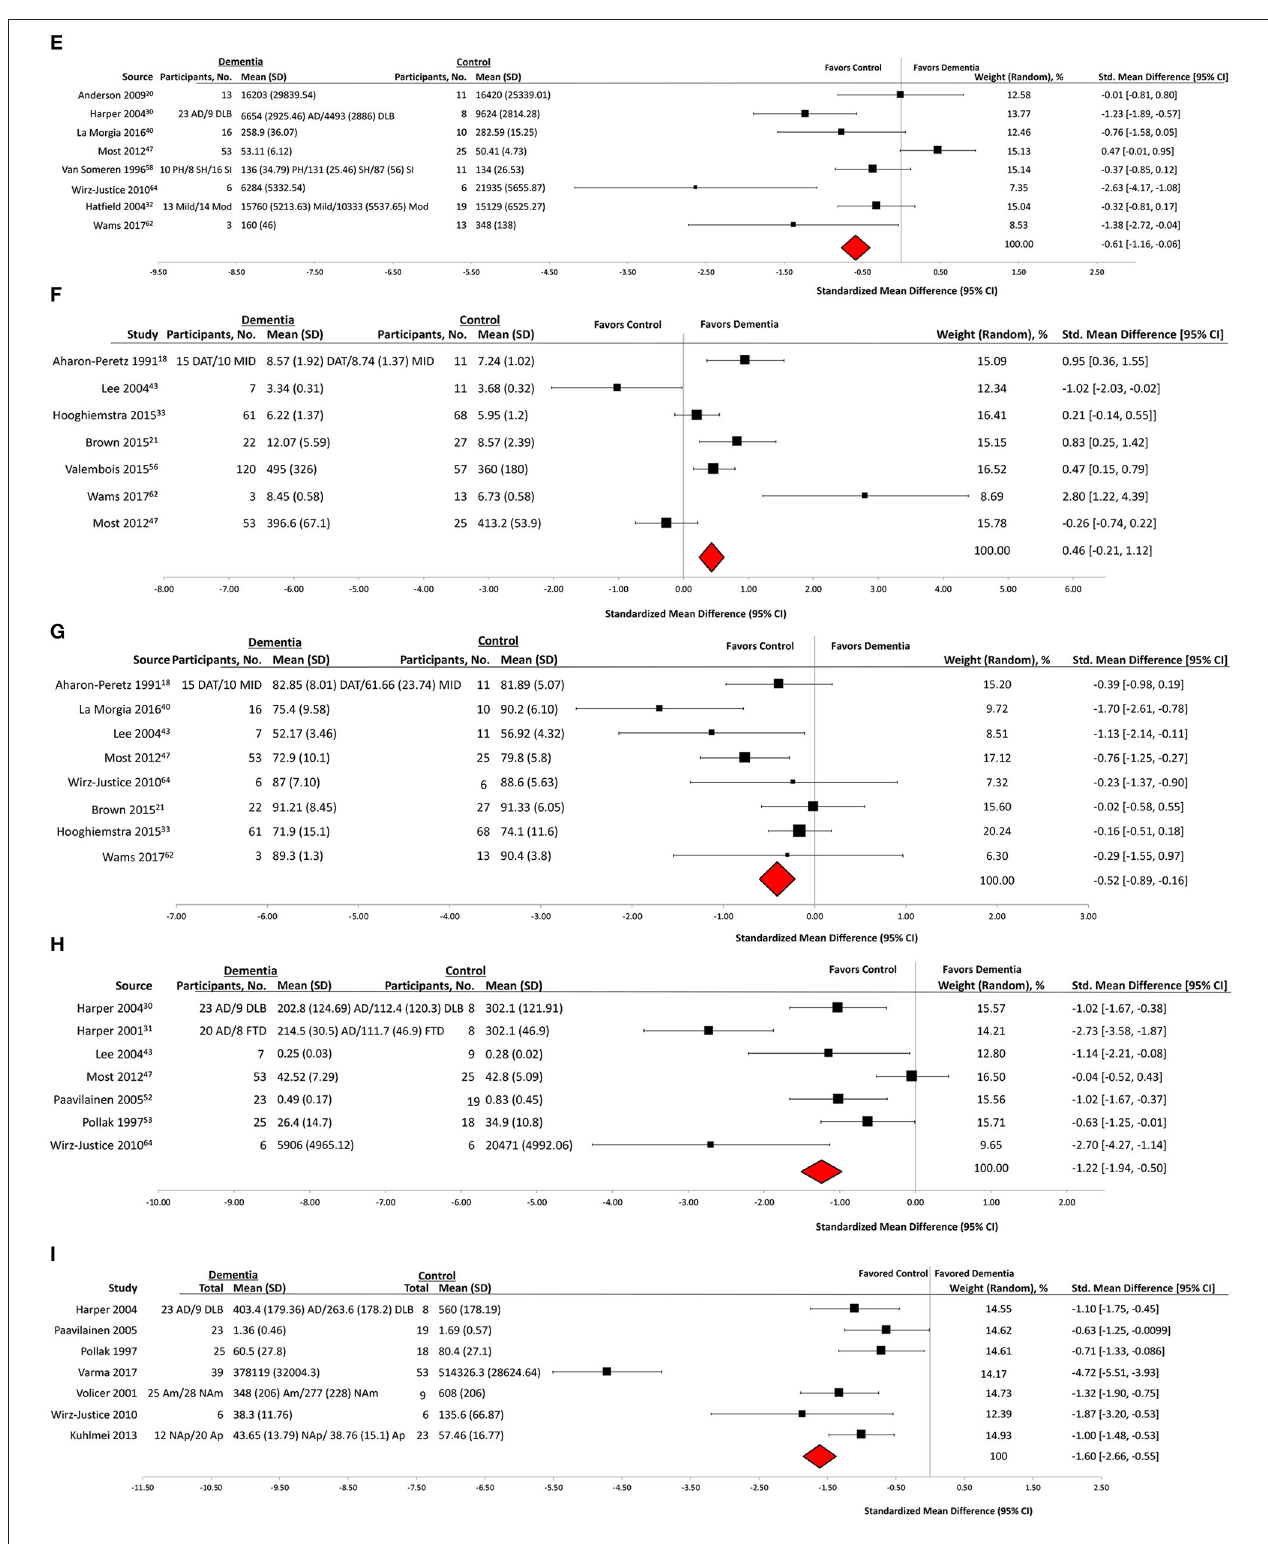
FIGURE 2 | Actigraphy outcomes in observational case control studies of wearable technology. (A) Interdaily stability, (B) interdaily variability, (C) relative amplitude, (D) activity of least active 5h, (E) Activity of most active 10h, (F) total sleep time, (G) sleep efficiency, (H) amplitude, and (I) daytime activity.